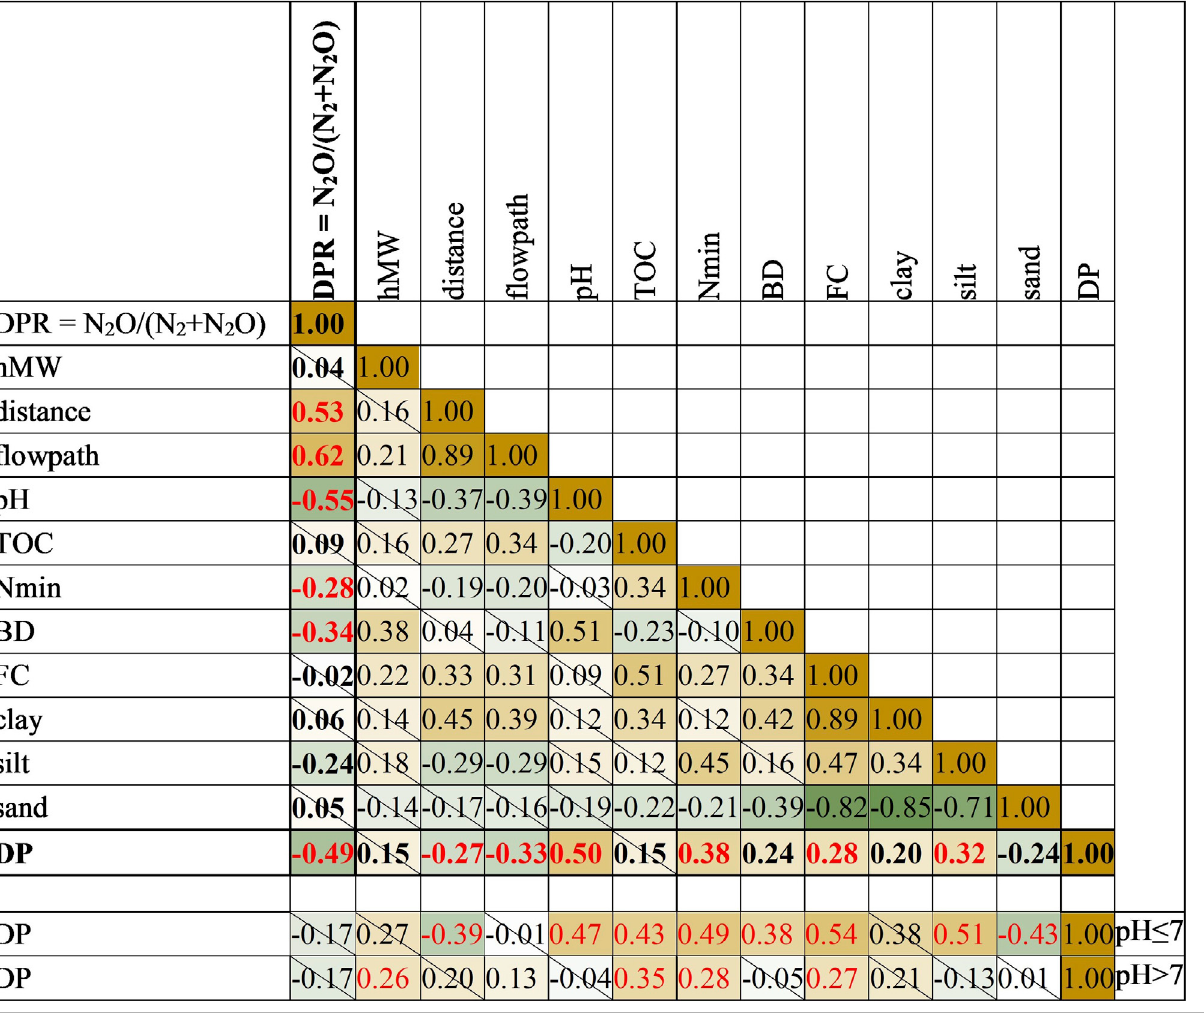
Frontiers in Earth Science |